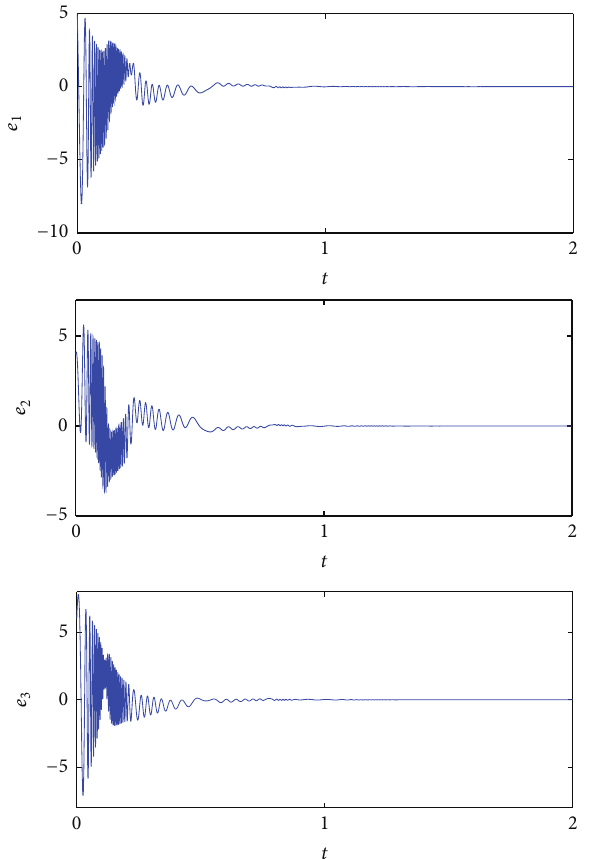
Figure 4: The SBDFPS errors between the scaling drive system (25), base drive systems (26), and response system